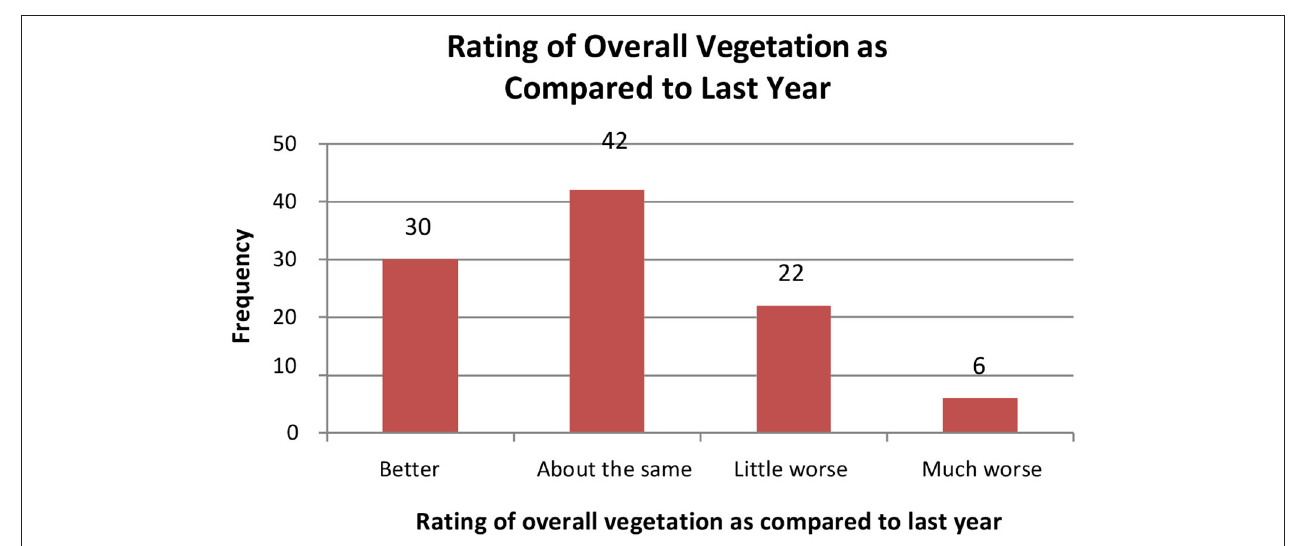
FIGURE 16 | Rating of the overall vegetation compared with last